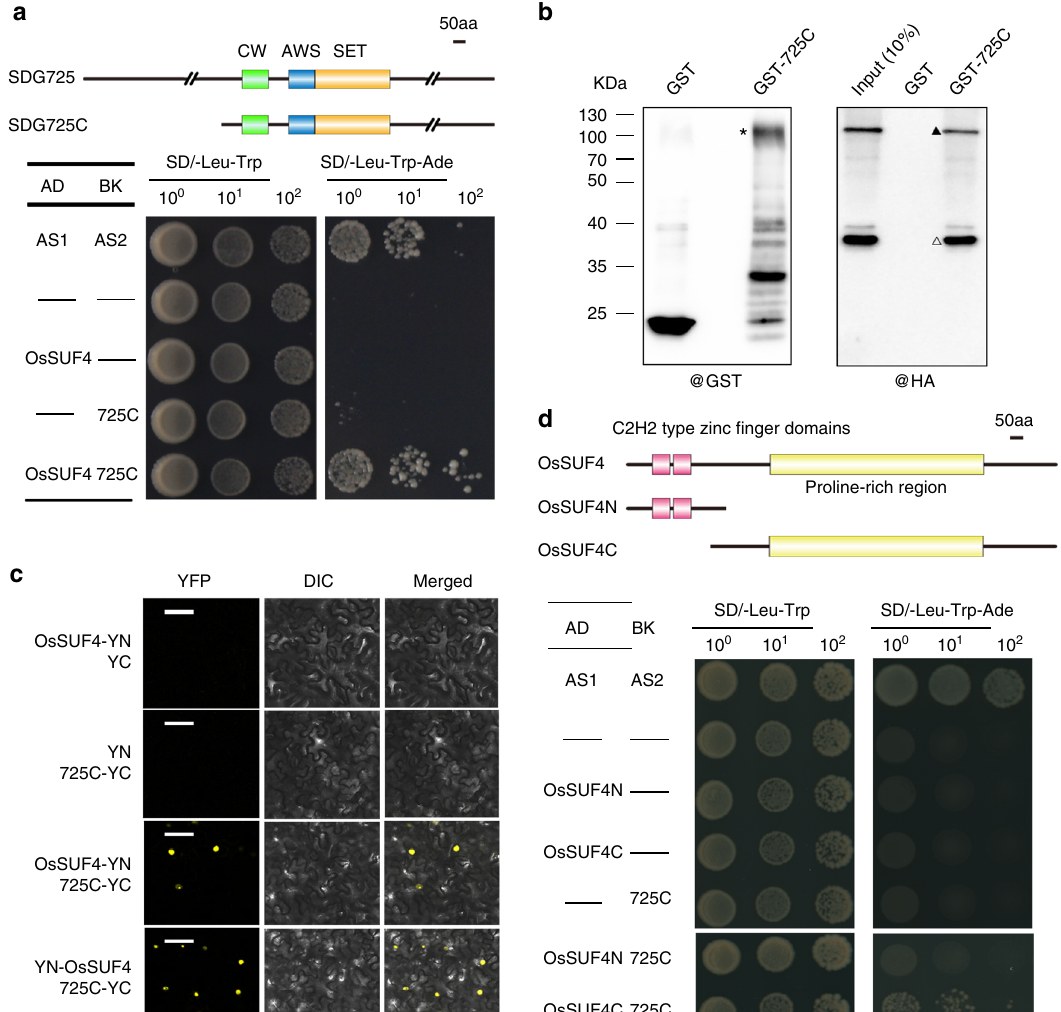
Fig. 2 OsSUF4 interacts with SDG725C in vitro and in vivo. a The interaction between OsSUF4 and SDG725C in a yeast two-hybrid assay. AS1 and AS2 serve as the positive control. Upper panel: Schematic representation of full-length and truncated SDG725 proteins. b The left panel showed GST and GST-SDG725C (GST-725C) proteins used in the pulldown assay, and the right panel showed HA-OsSUF4 pulled down by SDG725C using rice plants over- expressing HA-OsSUF4 . GST-725C, HA-OsSUF4, and a non-speci fi c band are marked with an asterisk, a triangle, and an open triangle, respectively. c BiFC experiments showing the interaction of OsSUF4 and SDG725C in Nicotiana benthamiana leaf epidermal cells (Bar = 50 µ m). DIC differential interference contrast, YN N-terminal of YFP, YC C-terminal of YFP. d Yeast two-hybrid fi ndings that the C-terminal domain of OsSUF4 (OsSUF4C) interacts with SDG725C. Upper panel: Schematic representation of full-length and truncated OsSUF4 proteins. AS1 and AS2 serve as the positive control. Source data are provided as a Source Data fi